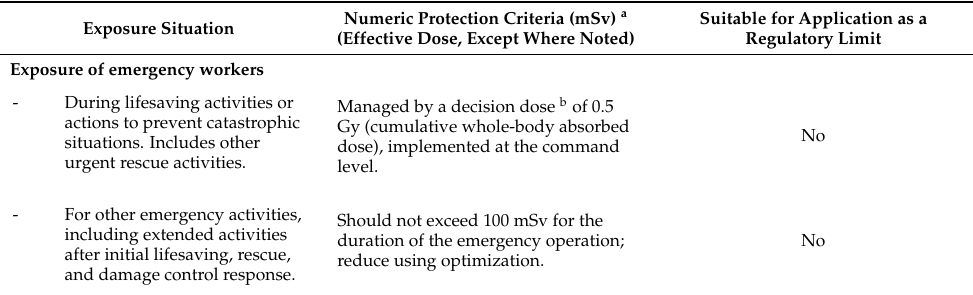
Table 3. Numeric protection criteria for the management of dose to an emergency worker, NCRP [2]— see Appendix C for a,b’s explanations.